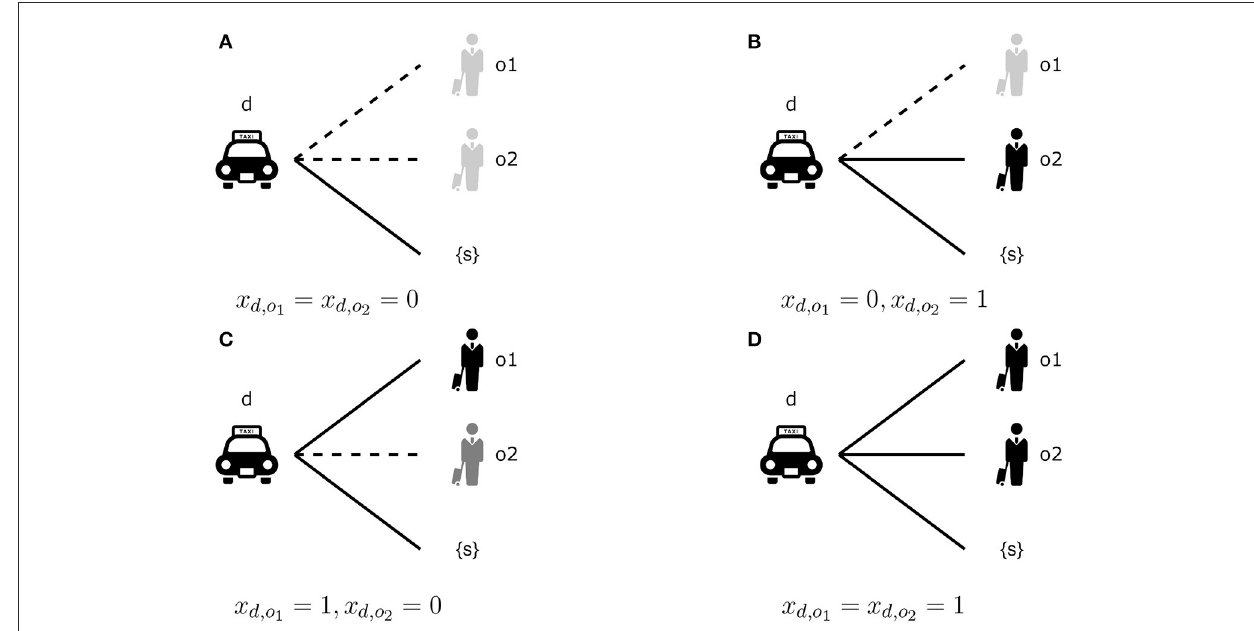
FIGURE3 Four possible disclosure instances. (A) means no choice is shown. (B, C) Mean only one order is displayed. (D) The case all orders are given to the driver d . Note that p d , o = 0 if x d , o = 0, i.e., a driver cannot select an order that is not